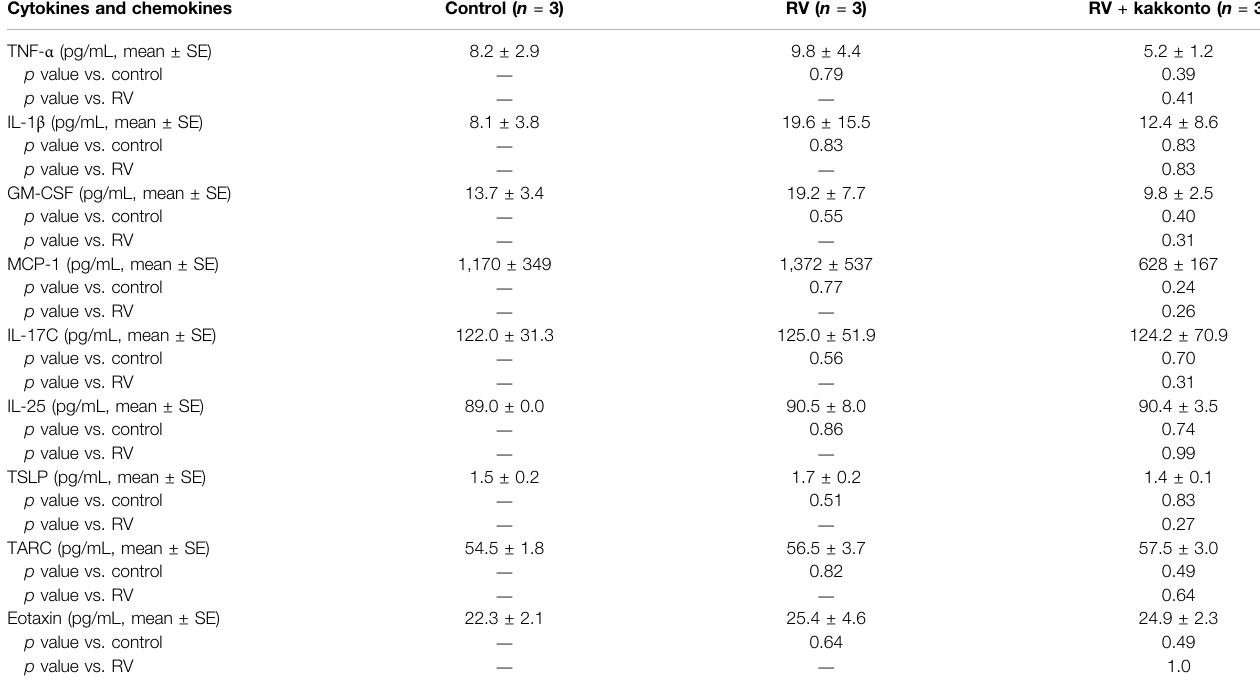
TABLE 3 | Cytokine concentration in the supernatants of HNE cells 24 h after RV infection. Cytokines and